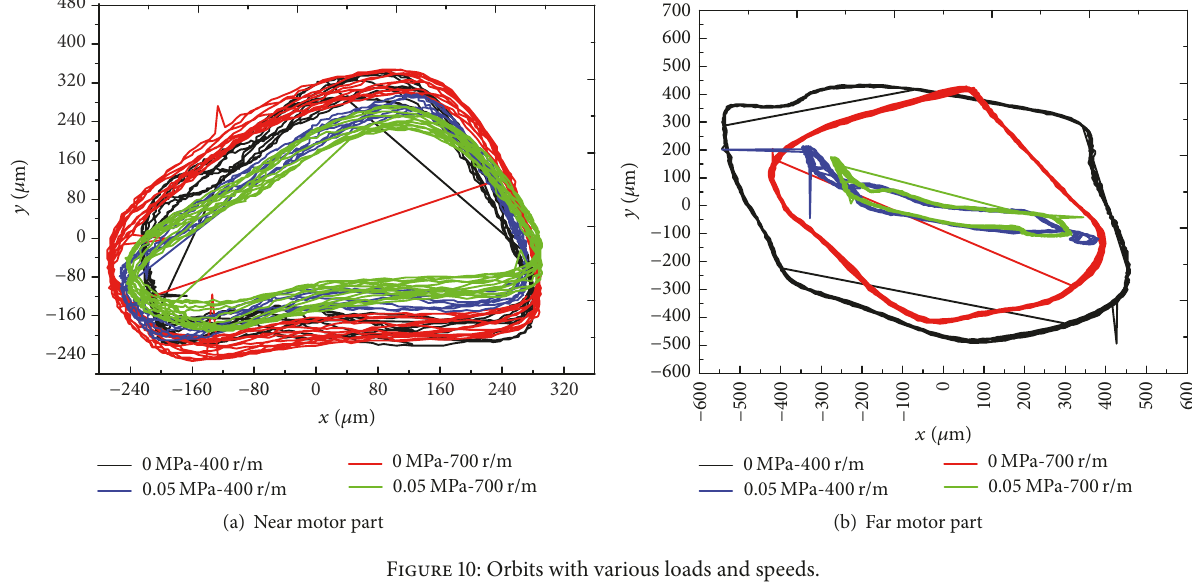
Figure 10: Orbits with various loads and speeds.